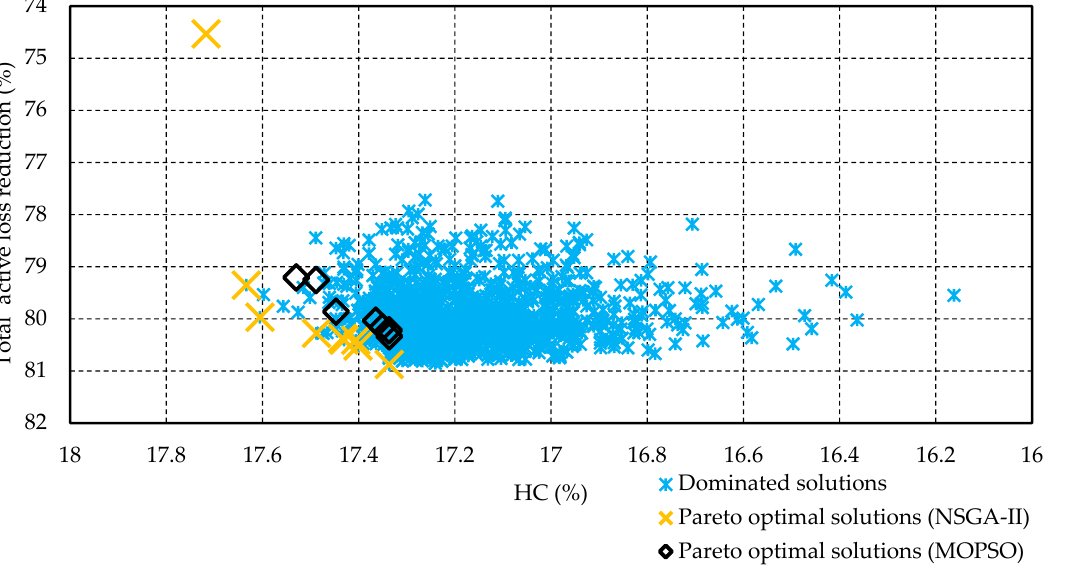
Figure 12. Pareto-front for the 415-node distribution network using NSGA-II and MOPSO. Table 5. Results for the studied distribution networks. Table 6. WT and PV distributed generations (DGs) sizes in MW at each node using